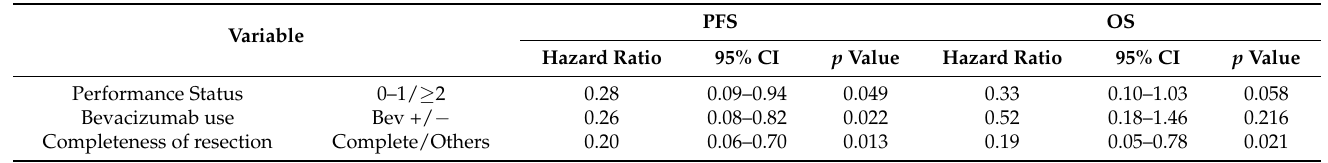
Table 3. Multivariable Cox proportional analysis of risk factors for progression-free survival and overall survival for advanced clear cell